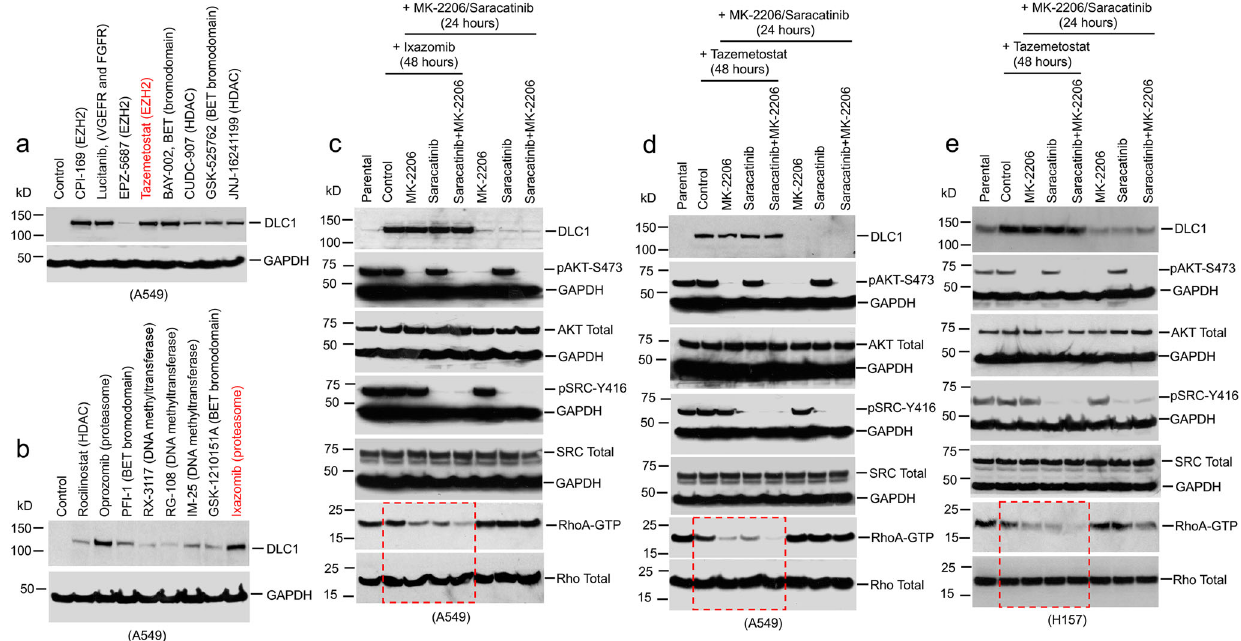
Fig. 1 EZH2 and proteasome inhibitors increase DLC1 protein in A549 and H157 NSCLC lines, whose Rho-GAP activity is increased by AKT and SRC inhibitors. a , b Steady-state DLC1 protein levels in A549 LUAD cells after 48 h treatment with the indicated inhibitors. GAPDH was used as a loading control. c , d Treatment with Ixazomib ( c ) or Tazemetostat ( d ) increases DLC1 protein in A549 cells. MK-2206 and/or Saracatinib treatment decreases RhoA-GTP in Ixazomib or Tazemetostat treated cells, but not in parental DLC1 protein-negative cells, although MK-2206 and Saracatinib inhibit AKT activity (measured by pAKT-S473) and SRC activity (measured by pSRC-Y416) in all treated samples. Combined treatment of MK-2206 and Saracatinib with Ixazomib or Tazemetostat further reduces RhoA-GTP. Cells were treated with Ixazomib or Tazemetostat for 48 h, with MK-2206 and Saracatinib added during the last 24 h period. e Steady-state DLC1 protein levels in H157 LUAD cells after 48 h treatment with Tazemetostat. MK-2206 and/or Saracatinib treatment decreases RhoA-GTP in parental DLC1 protein-positive cells. Tazemetostat treatment by itself increased the level of DLC1 protein, and the AKT and/or SRC kinase inhibitors in the cells containing Tazemetostat reduced RhoA-GTP to an even greater degree than in the absence of Tazemetostat. Two independent experiments were performed for a – e with similar results. Source data are provided as a Source Data fi